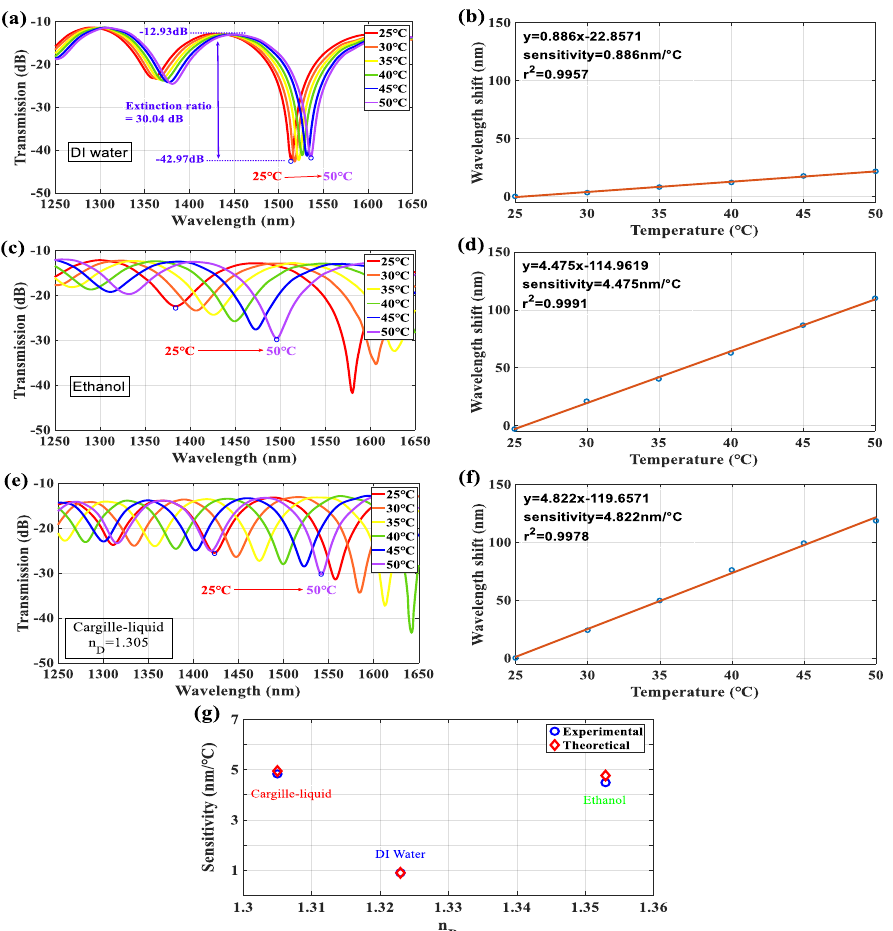
Figure 4. The schematic diagram of the measured system for the LLCFMZI.